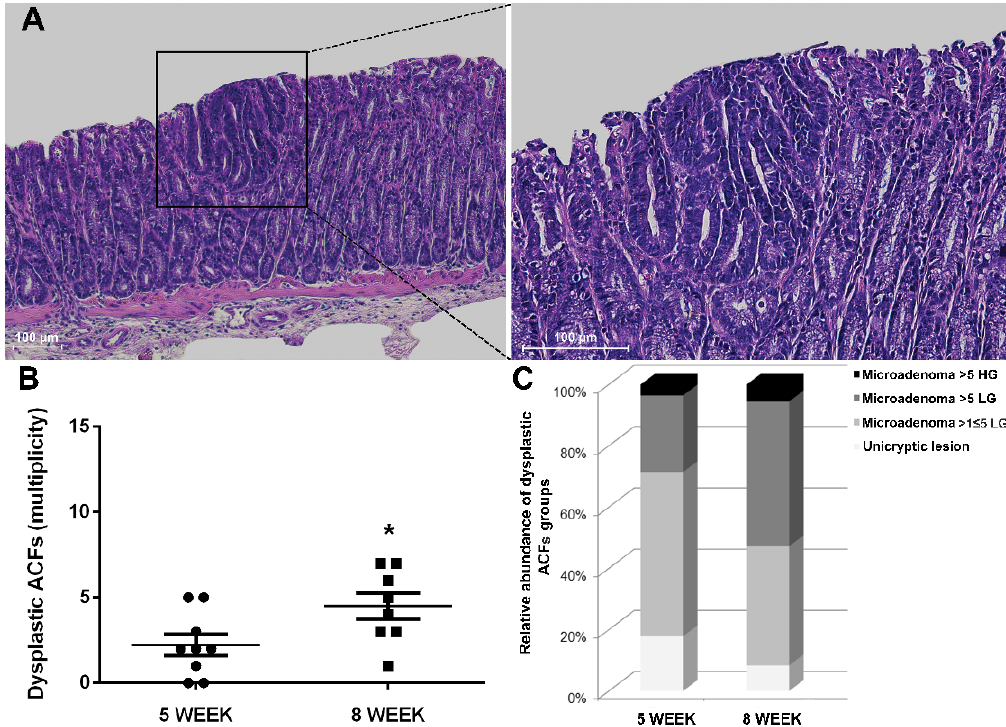
Figure 5. Histological analysis of 8-week-old Winnie- APC Min /+ mice. ( A ) Hematoxylin and eosin staining on 3μm distal colon sections. Images were captured at 10× (left) and 20× magnifications (right). ( B ) Dot plot shows CRC progression from 5 to 8 weeks for Winnie- APC Min/+ mice as mean ± SEM of dysplastic ACFs. ( C ) Histograms show dysplastic ACFs composition in terms of dimension and grading for Winnie- APC Min/+ mice at 5 and 8 weeks. 5-week: n = 8–10 animals/group; 8-week: n = 8 animals/group. * p < 0.05.